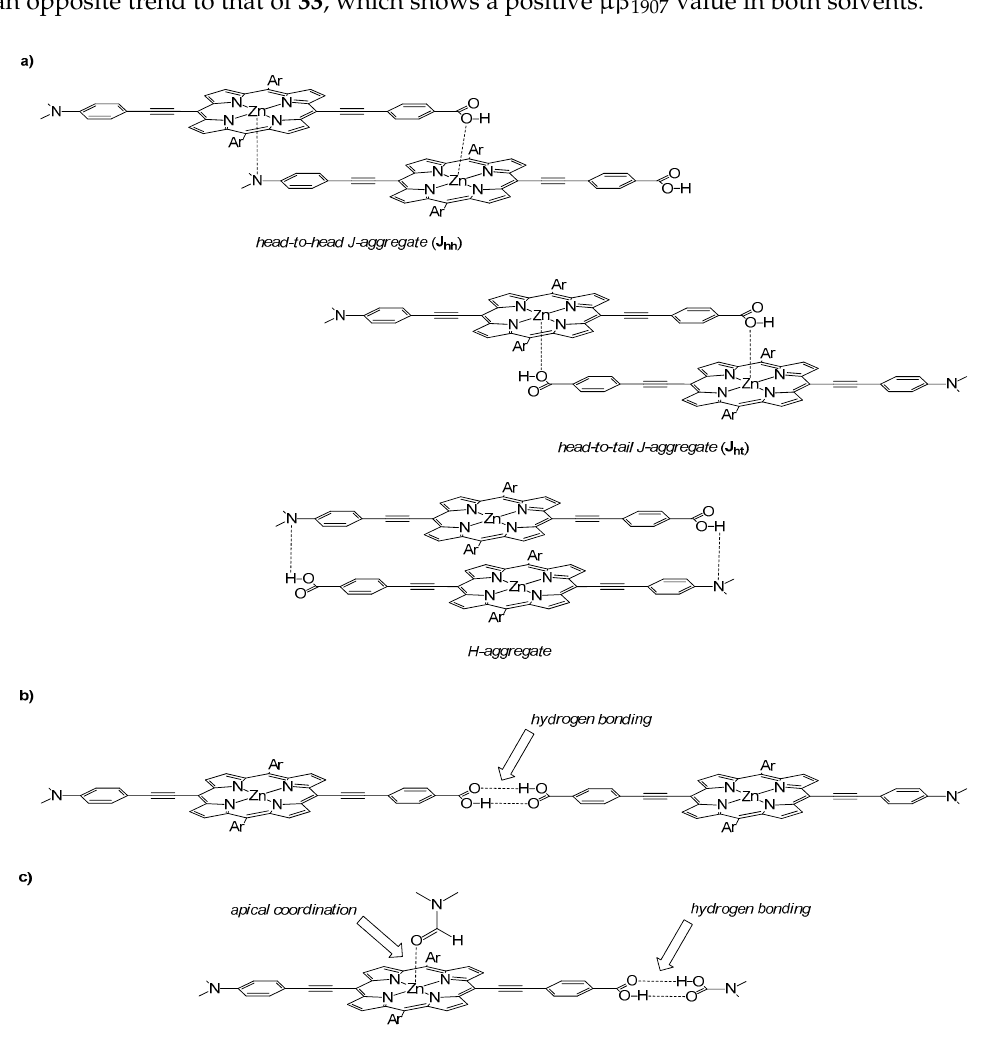
Figure 6. Schematic representation of possible aggregation in CHCl 3 and DMF solution. ( a ) J hh , J ht , and H aggregates; ( b ) hydrogen bonding; ( c ) axial coordination of the solvent DMF and hydrogen